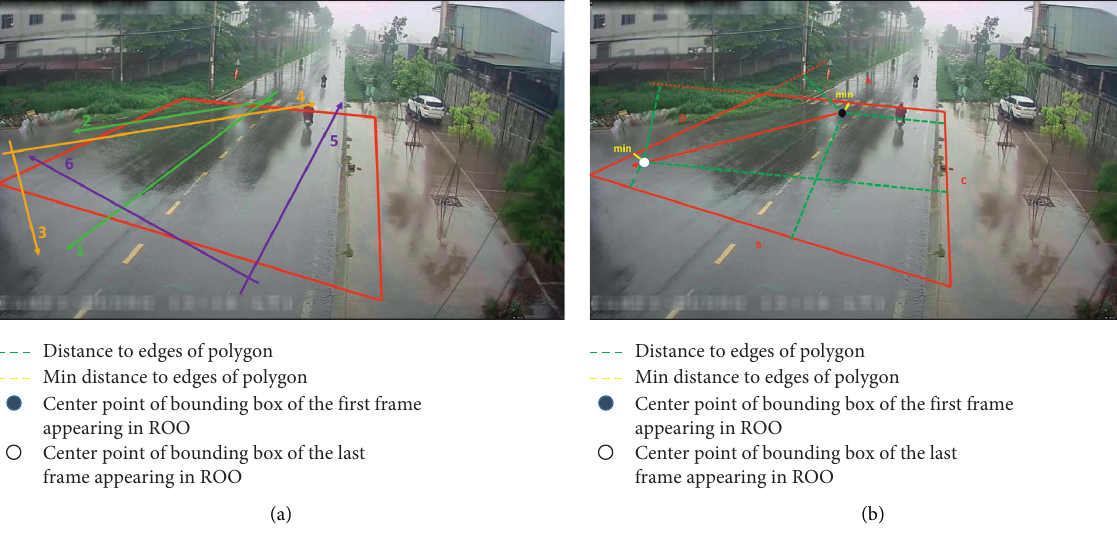
Figure 8: Illustration of min distance calculation method in intersection scenarios: (a) an intersection with six moving directions labeled from 1 to 6 (POO and predefined DOM) and (b) illustration of the min distances and distance to edges used to count the vehicles moving following direction number 2 (calculating min distance).